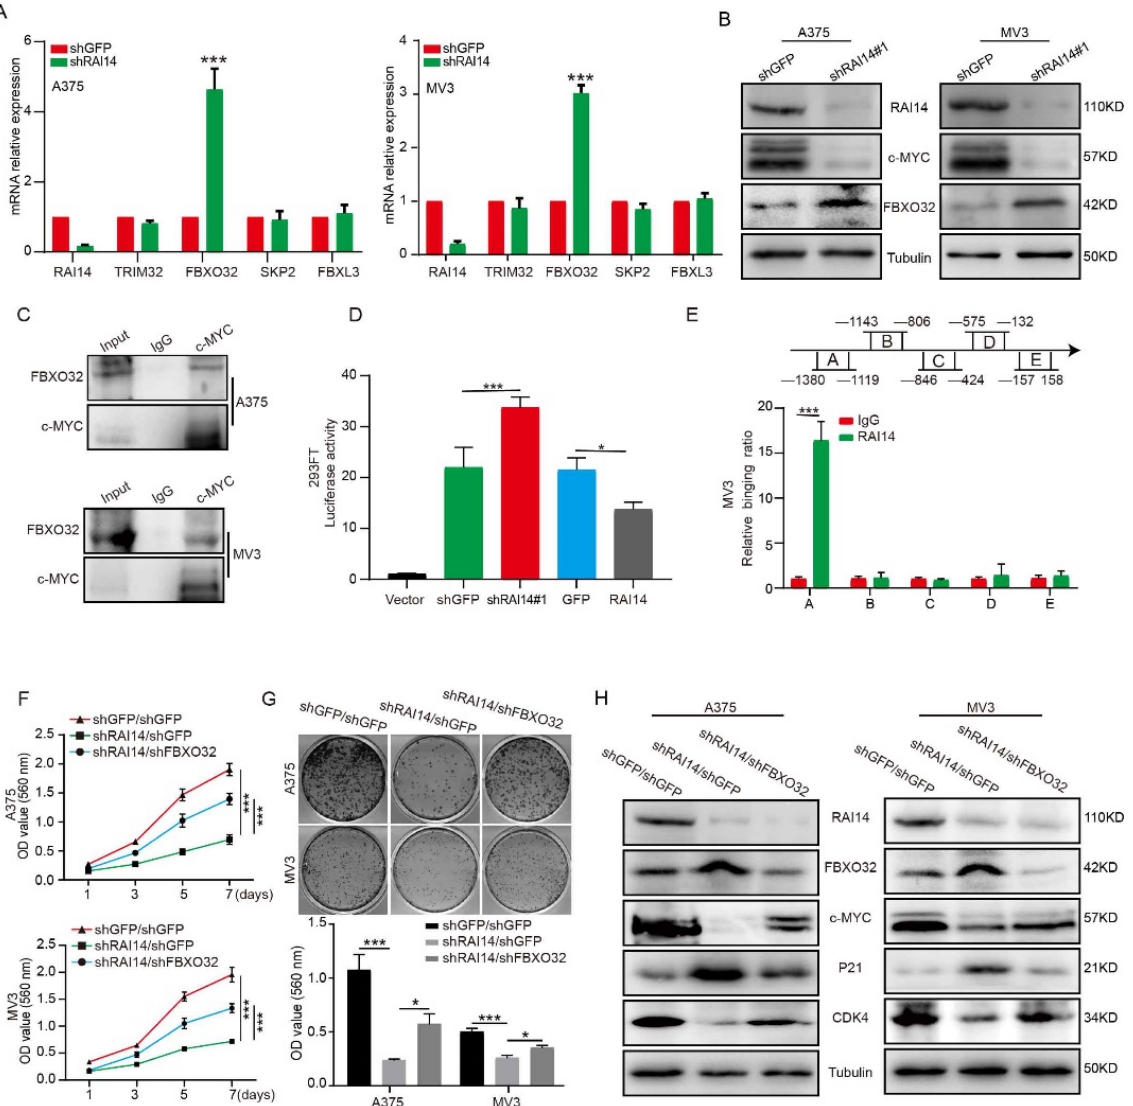
Figure 5. RAI14 suppressed the transcription of FBXO32. ( A ) The mRNA expression level of c-MYC- related E3 ligase was detected through qRT-PCR assay. ( B ) FBXO32 protein expression level